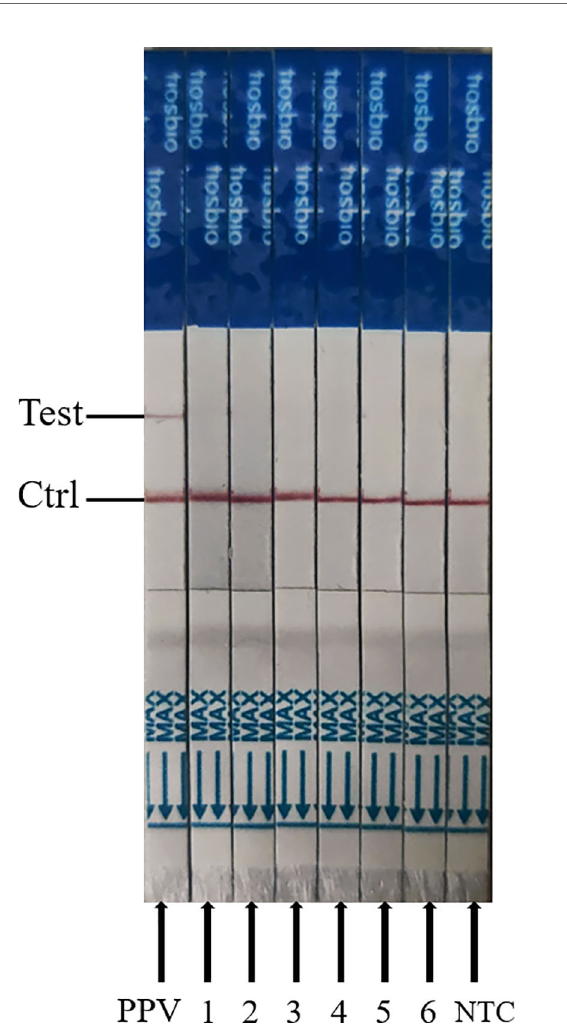
FIGURE 6 | Analytical sensitivity results of ERA-CRISPR/Cas12a/LFD for the plasmid; 10 6 to 10 0 indicate tests with 3.75 × 10 6 to 3.75 copies/ m L recombinant plasmid as a template. NTC indicates a test with RNase-free ddH 2 O as a template.